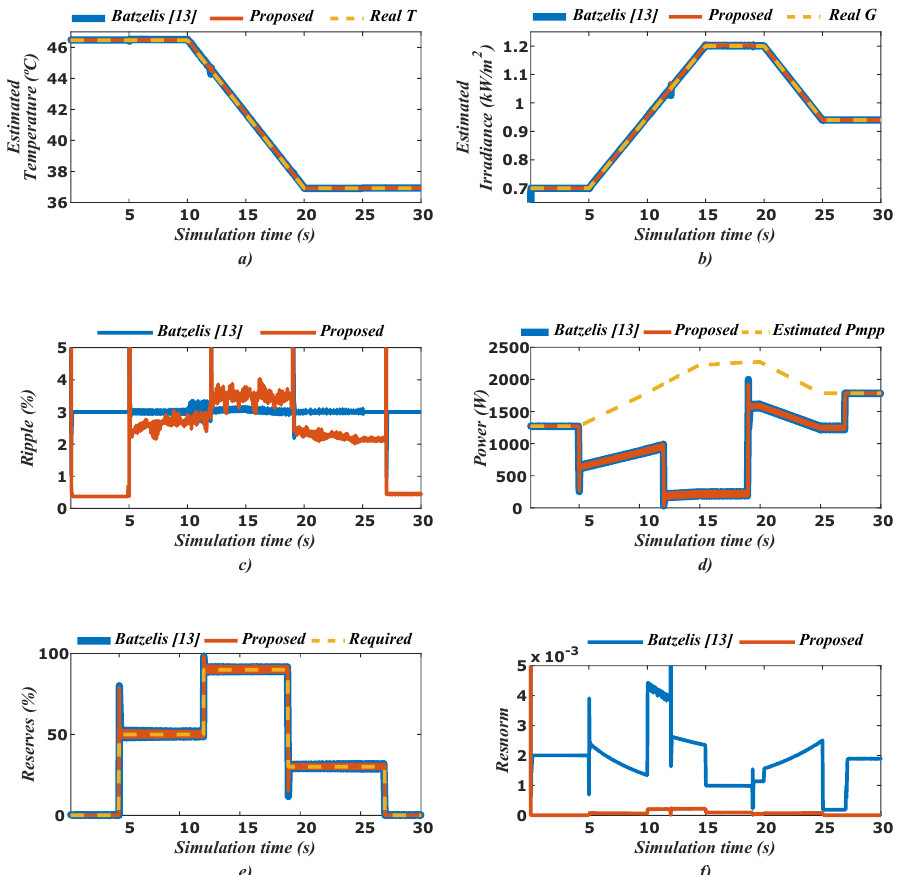
Figure 16. Case Study #3: ( a ) Temperature evolution, ( b ) Normalized irradiance evolution, ( c ) Ripple evolution, ( d ) Power evolution, ( e ) Reserves evolution and ( f ) Squared 2-norm residual